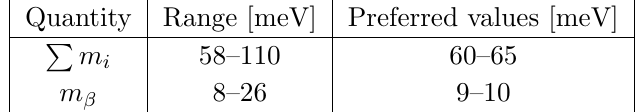
Table 8 . Range of predictions for P m i and m (cid:12) scanning over (cid:12)ts with Dirac Neutrino charges X N = X N = 5 ; 6 and (cid:31) 2 < 20 and (cid:31) 2 a 3 most